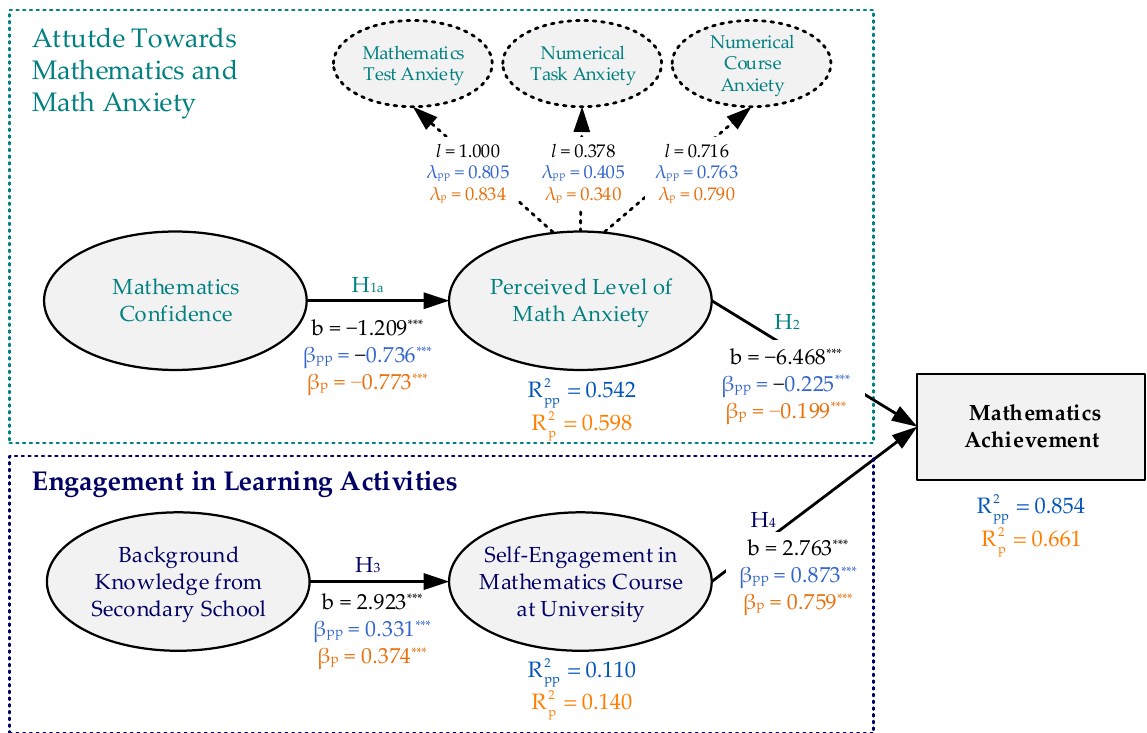
Figure 7. Relationships among constructs of final model. Note: l —Unstandardized loading, λ —Standardized loading, b—Unstandardized path coefficient, β —Standardized path coefficient, R 2 —Coefficient od determination, pp—Pre-pandemic, p—Pandemic, *** p <